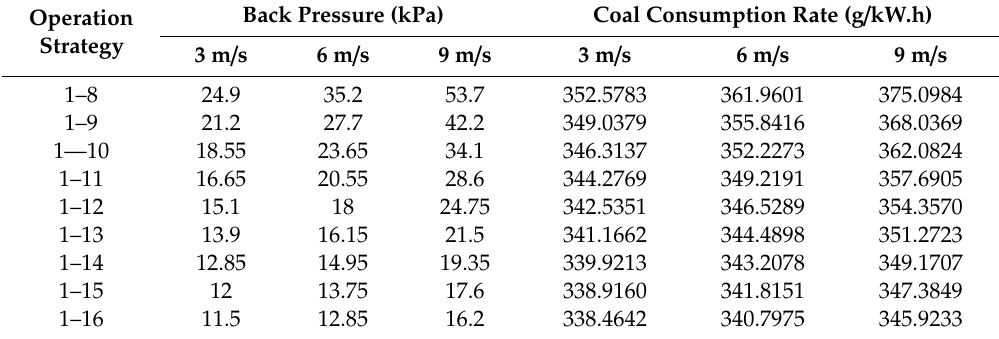
Figure 6. Variations of the back pressure and coal consumption rate with the number of ACC cells under different ambient winds. Table 3. Backpressure and coal consumption rate with the number of ACC cells under di ff erent ambient winds in 30 ◦